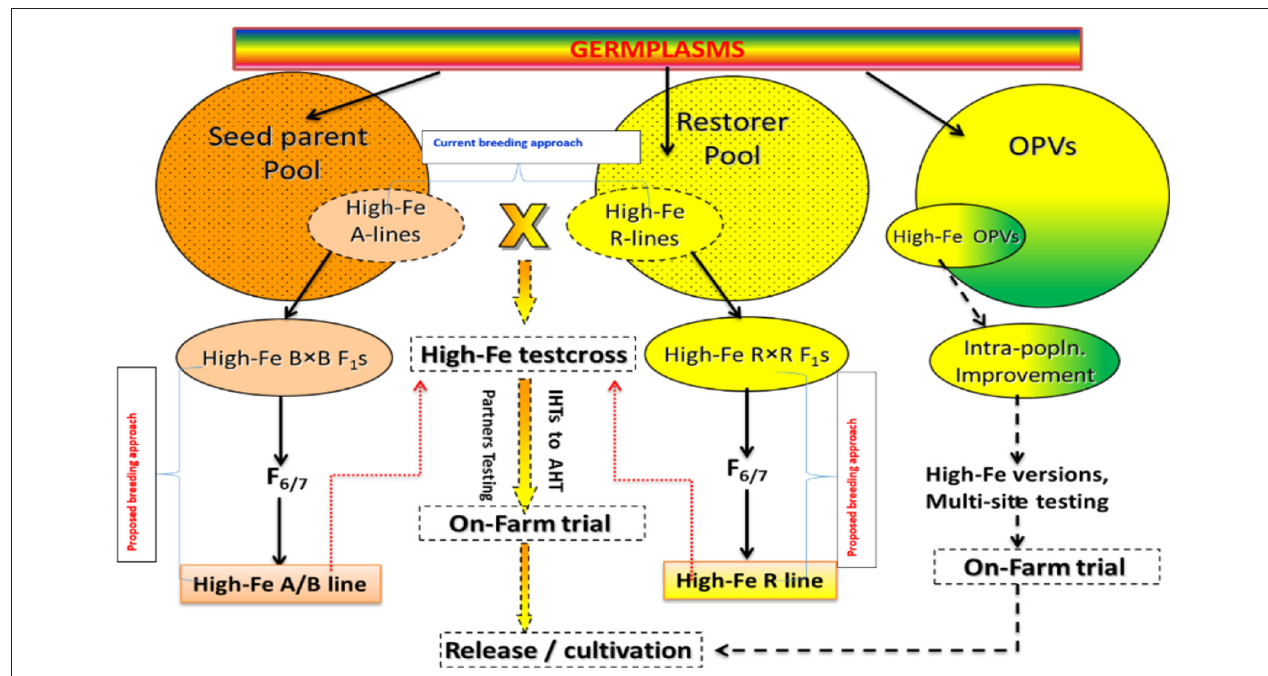
FIGURE 7 | Current breeding approaches followed for developing biofortified cultivars in pearl millet (Adapted from: Govindaraj et al.,